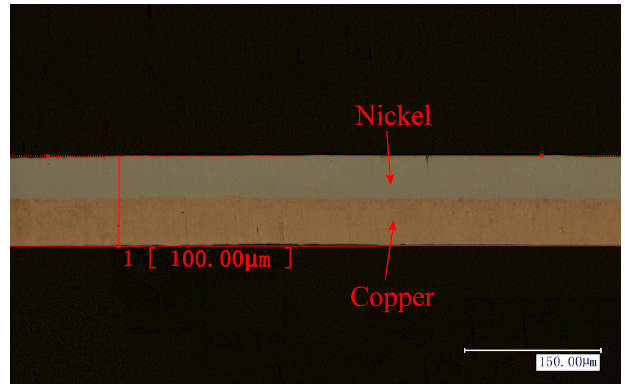
Figure 1. The cross section of the Cu/Ni composite sheets under an optical microscope.